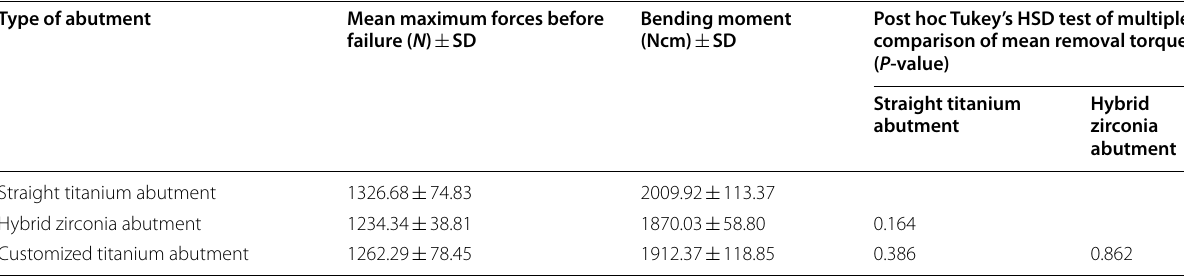
Table 2 Mean maximum forces before failure (N) and bending moment in all abutment groups Type of abutment